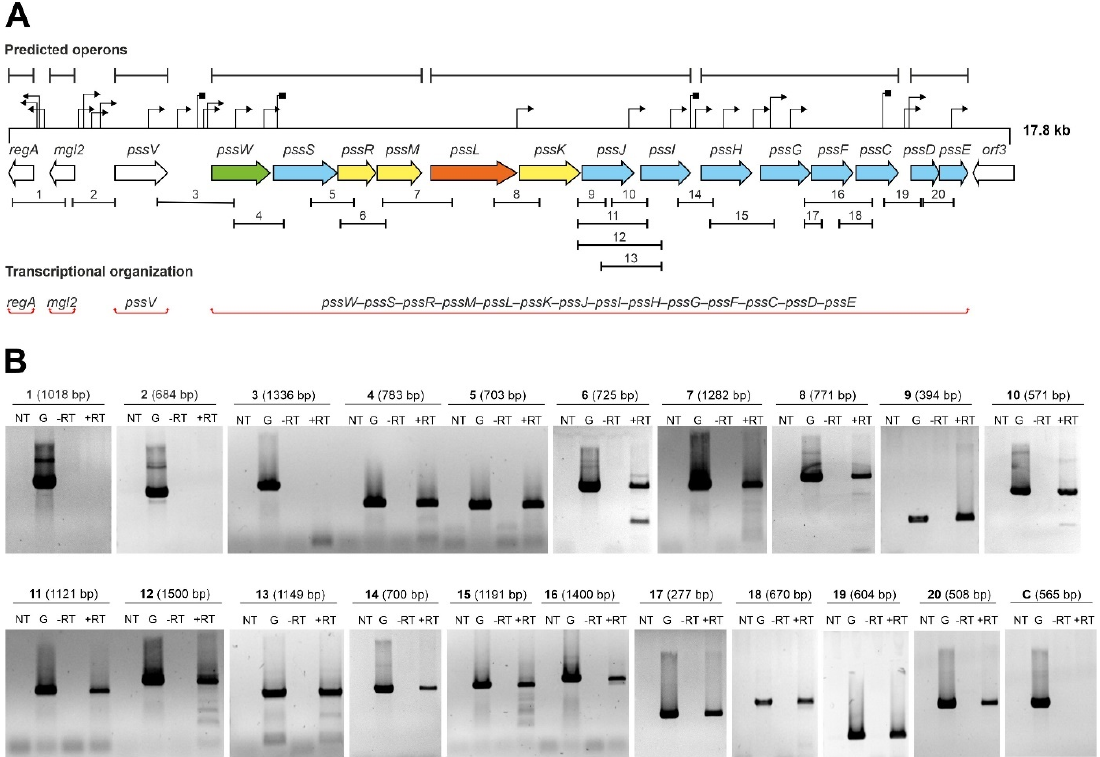
Figure 1. Analysis of the transcriptional organization of genes encoding GTs: ( A ) 17.8 kbp fragment of the 5 ′ end of the RtTA1 Pss ‐ I region. The arrows represent individual open reading frames in the Pss ‐ I region. The colors of the arrows indicate genes with the following confirmed or predicted functions: blue—GTs; yellow—EPS subunit modification; orange—flippase; green—EPS processing; and white—other or unknown functions. The upper part of the panel shows in silico predicted operons (black sections), promoters (black triangles), and terminators (black squares). The PCR-amplified fragments are marked below the arrows representing corresponding genes. The genes that have been experimentally verified to function as one operon are highlighted in red sections in the lower part of the panel. ( B ) Results of the PCR reactions with primers covering the intergenic regions of the studied gene cluster. The numbers correspond to the sections marked in panel ( A ). The sizes of the amplified DNA fragments are given in parentheses. The symbols mean: ‘NT’—control reaction without template DNA; ‘G’—control reaction with RtTA1 genomic DNA; ‘ − RT’—control reaction with isolated total RNA without reverse transcription; and ‘+RT’—reaction with cDNA as a template. The amplicon marked as ‘C’ is an additional negative control to indicate no genomic DNA contamination of the RNA preparations (Supplementary Table S1).